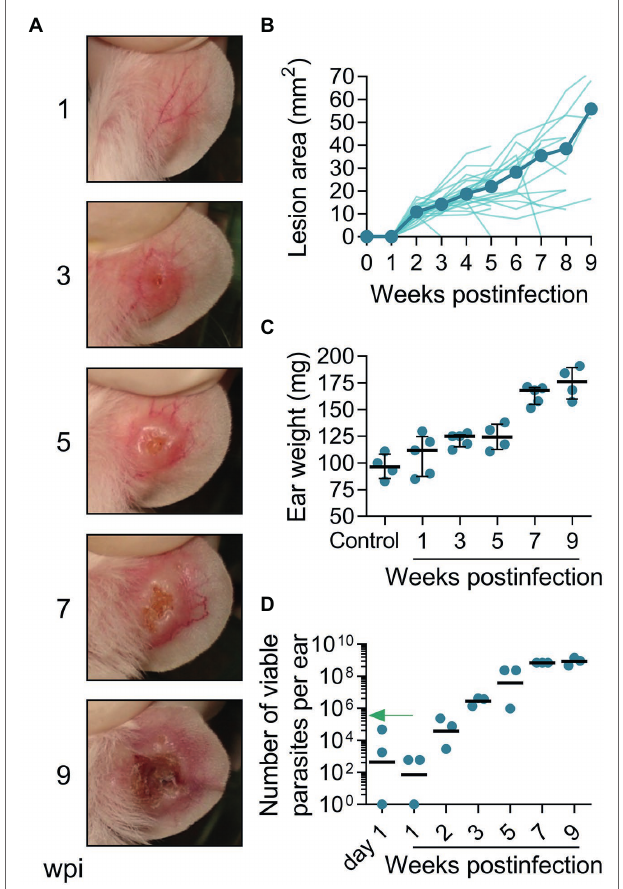
FIGURE 2 | Infection with L(V)p in the ear dermis induces chronic ulcers that closely resemble human CL. BALB/c mice were infected with 10 5 L(V)p stationary promastigotes id in the right ear and monitored weekly. Representative photographs at the indicated time postinfection are presented (A) . The size of the lesion was measured and graphed as the median [thick line] and for each individual mouse [thin lines] (B) . At the indicated time, mice were sacrificed, and the ears removed to measure the weight (C) as an indicator of inflammation. Results are presented as the median ± interquartile range in (C) . The number of viable parasites (D) in the ears was also determined by limiting dilution and graphed, with lines representing the geometric mean. The arrow in (D) indicates the infective inoculum. n = 3–5 mice per time. wpi: weeks